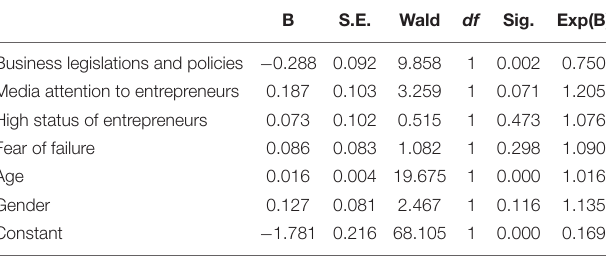
TABLE 1 | Description of constructs. TABLE 3 | Logistic regression (DV = intention to start a small business).